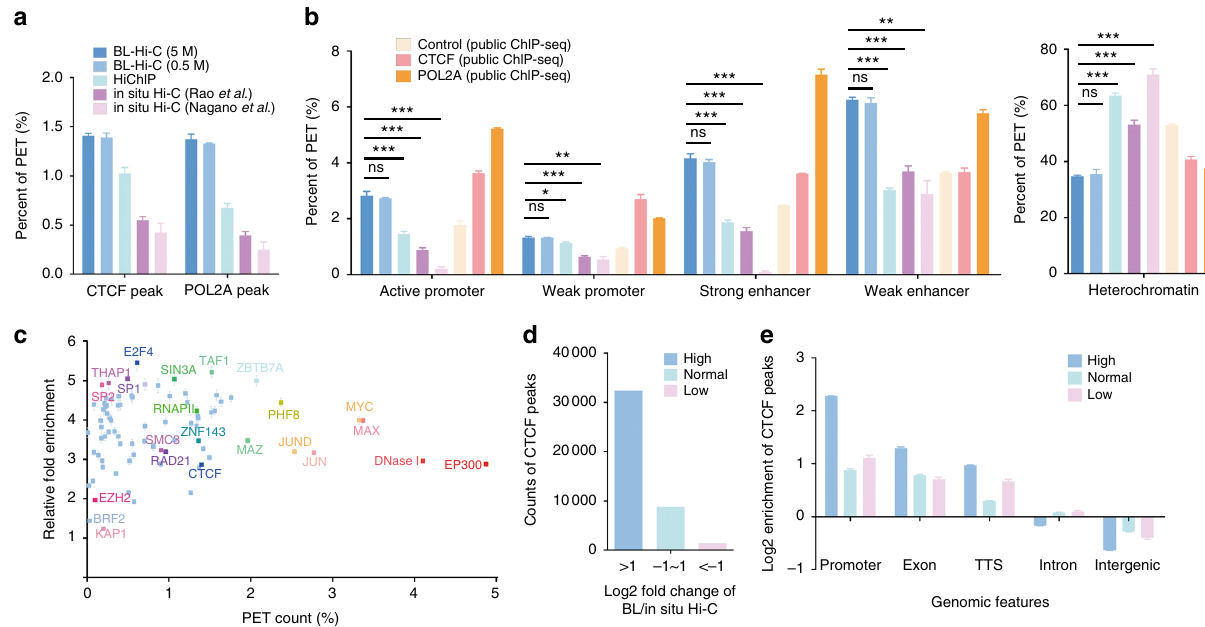
Fig. 2 Enrichment in the BL-Hi-C method. a The percentage of PETs that are consistent with public CTCF- and RNAPII-binding sites for BL-Hi-C (blue), in situ Hi-C (purple), and HiChIP (green). b The percentage of PETs that are consistent with ChromHMM-annotated DNA elements for BL-Hi-C (blue), in situ Hi-C (purple), and HiChIP (green). The enrichment patterns are indicated by comparing the public ChIP-seq data of CTCF (pink), RNAPII (orange), and the control (light yellow). The P -value is calculated by comparing BL-Hi-C to in situ Hi-C and HiChIP (two-sided t -test, ** P < 0.01, *** P < 0.001, error bar, s.e.m.). c The relative fold enrichment of BL-Hi-C PETs at transcription factor-binding sites. The x -axis represents the percentage of BL-Hi-C PET counts. The y -axis represents the PET count ratio between BL-Hi-C and in situ Hi-C (Rao et al .) at each TF-binding site. d The classi fi cation of public CTCF peaks into high, normal, and low for fold changes of > 1, from − 1 to 1, and < − 1, respectively, between BL-Hi-C and in situ Hi-C (Rao et al.). The y -axis refers to the counts of CTCF peaks for each group. e The enrichment of high (blue), normal (green), and low (pink) grouped CTCF peaks at genomic